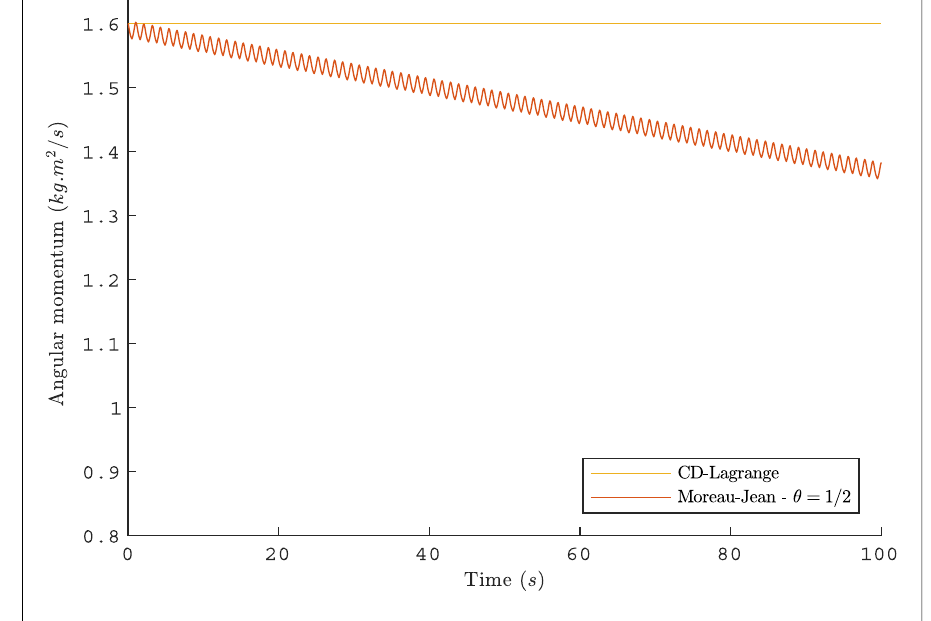
Fig. 16 Angular momentum-frictionless contact